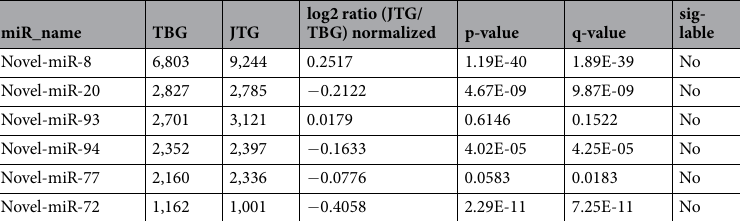
Table 2. Novel miRNAs in ovarian libraries with expression higher than 1,000 read